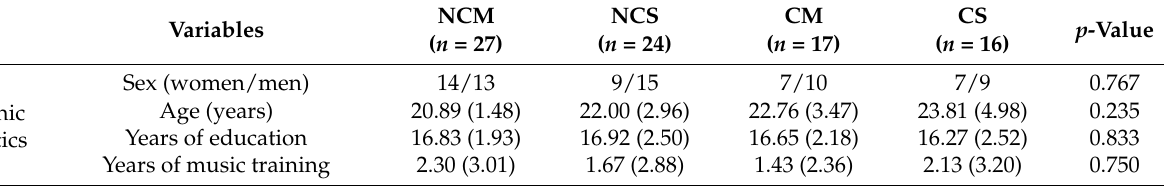
Table 1. Characteristics of participants in each